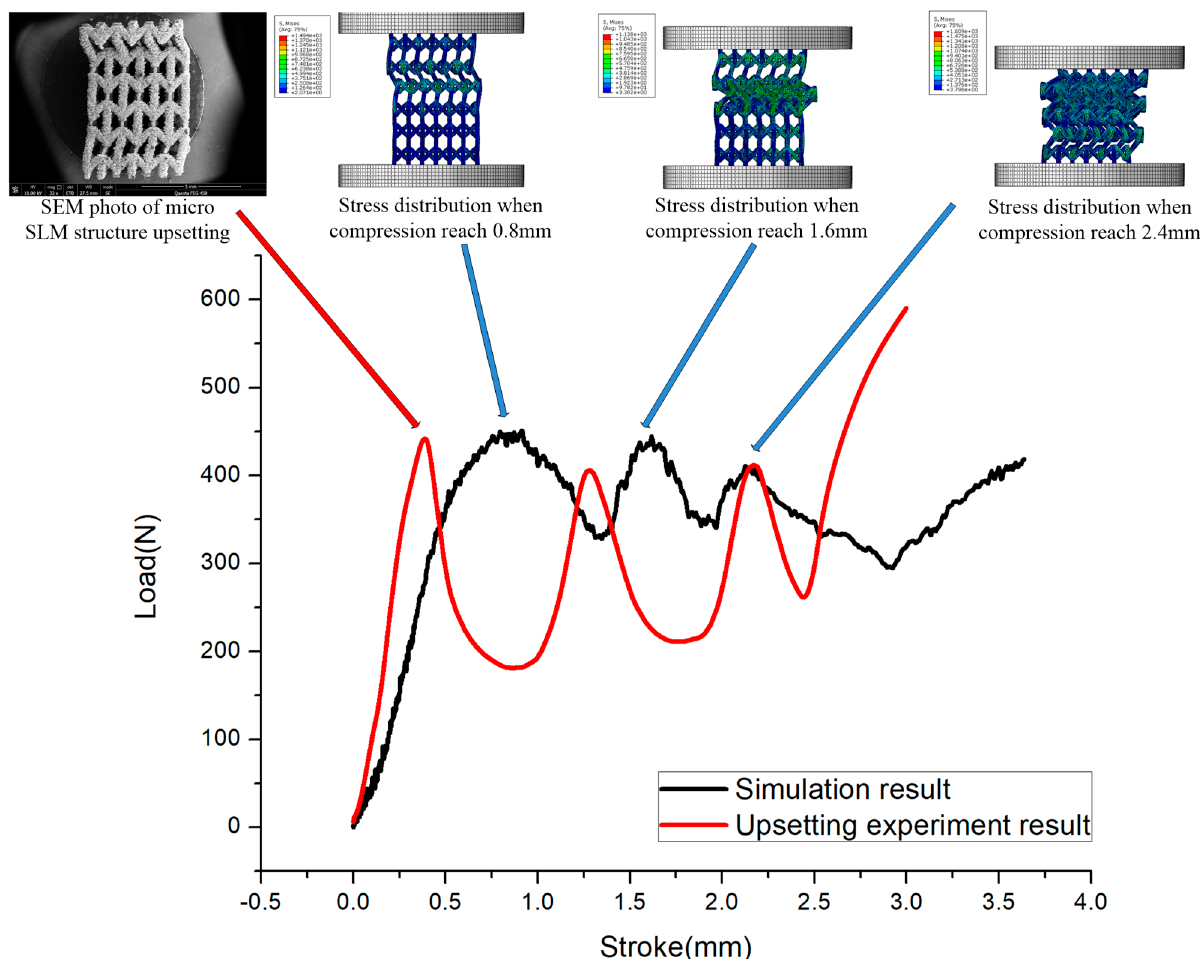
Figure 11. Load-stroke curve of micro auxetic structure obtain via FE simulation and actual experiment.